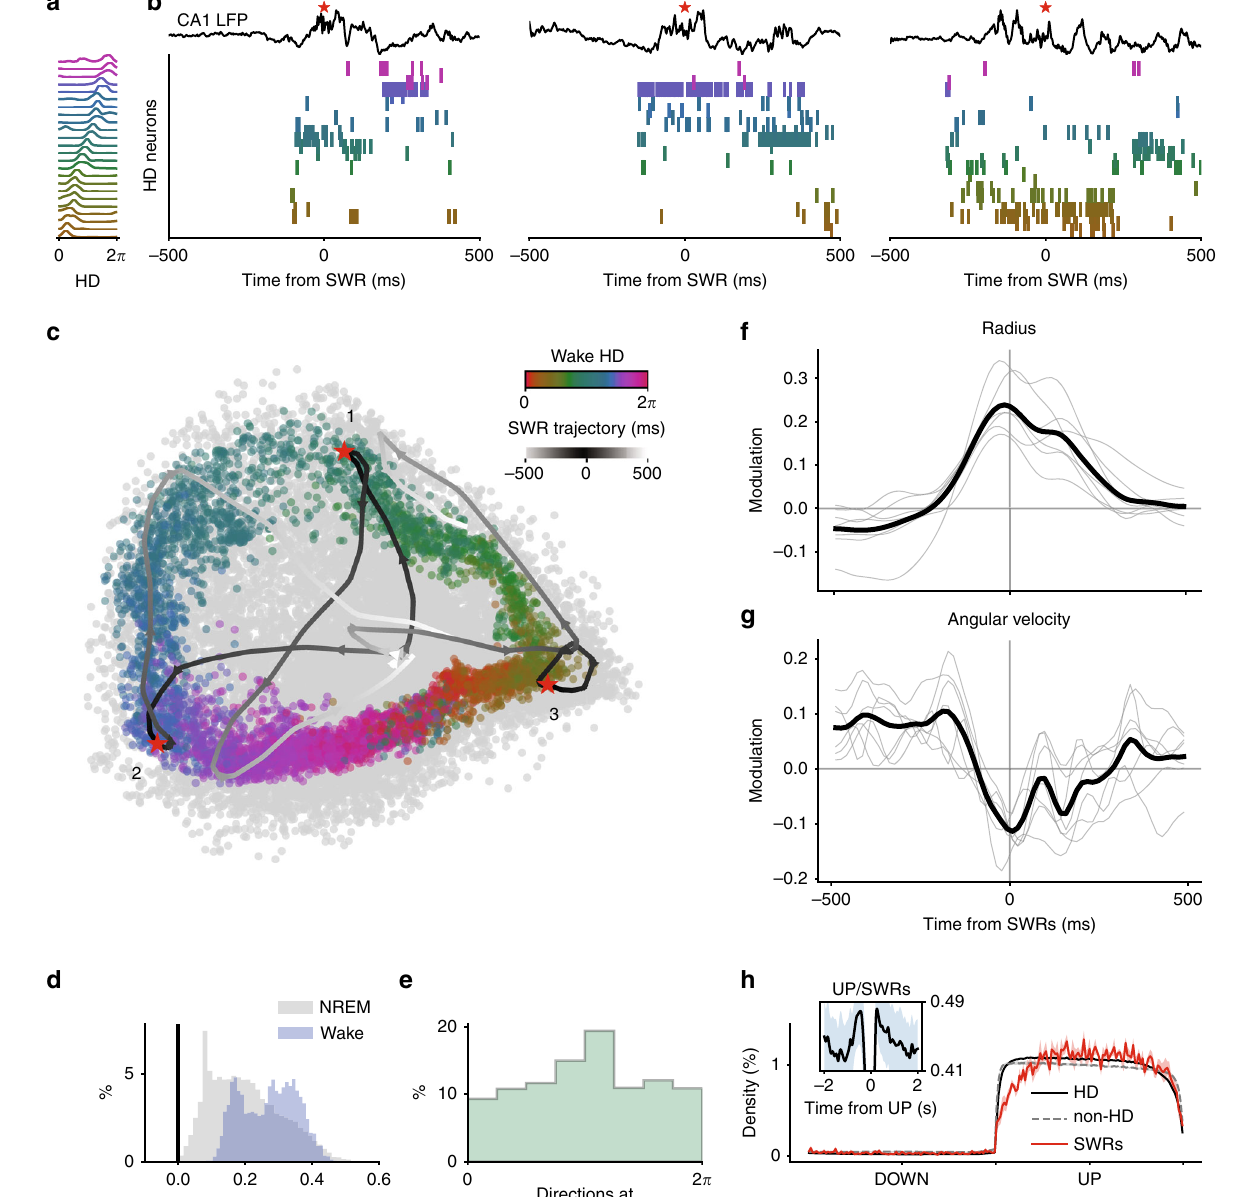
Fig. 1 Stability of HD decoding before SWRs. a – e HD decoding with ISOMAP around time of SWRs for one example session. a Tuning curves of HD neurons recorded simultaneously in the AD nucleus. b Simultaneous recording of CA1 pyramidal layer LFP (top) and neuronal activity in AD (same neurons as in a ) around the time of SWRs during NREM sleep. Spikes from HD neurons are sorted according to their preferred direction during wakefulness (as in a ). Red asterisks indicate SWRs. c Two-dimensional embeddings (using ISOMAP) of HD neuronal population activity during wakefulness and around the times of SWRs (colored and gray points, respectively). Curves display the population activity embeddings of the three examples shown in b (same red asterisks). d Distribution of distances from the embedding center ( c ) during wakefulness (blue) and NREM sleep (gray). e Distribution of average angular directions around the time of SWRs (±30 ms). f Average normalized radii (i.e. distance from embedding centers relative to shuf fl es) around times of SWRs (gray lines; n = 7 sessions, 3 animals) and session-wide average (black line). g Same as f for angular velocity (i.e. angular displacement between two consecutive activity bins). h Average density of spikes (±s.e.m.) for simultaneously recorded HD (black) and non-HD (gray) neurons, and rate of occurrence of SWRs (red line) during DOWN and UP states (normalized